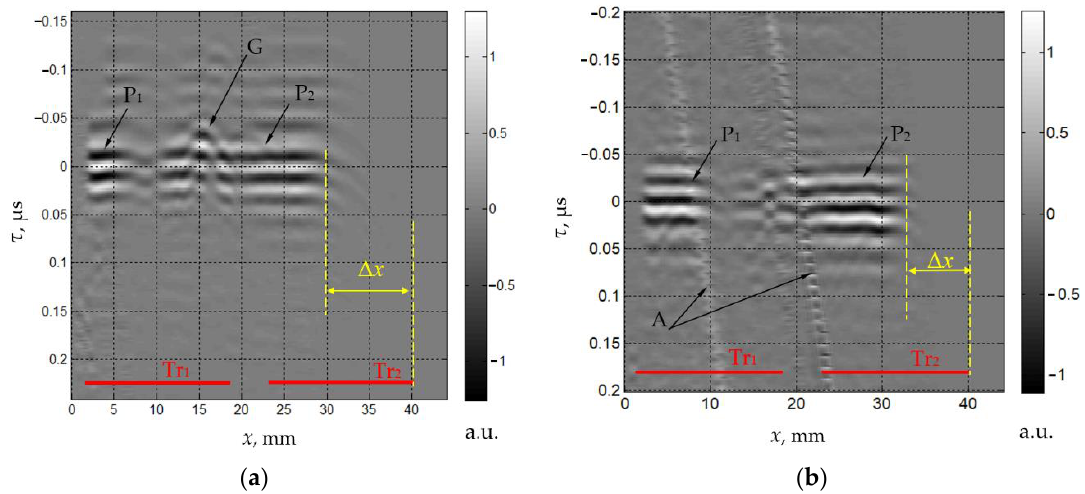
Figure 4. Measured spatio-temporal signals S LLL ( x , τ ) ( a ) and S LTT ( x , τ ) ( b ). The LLL wave formed by triple passes of the longitudinal wave is shown in Figure